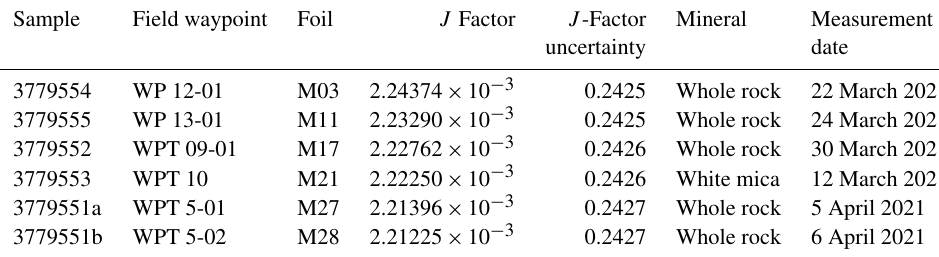
Table B2. J factors and the measurement dates of the samples.